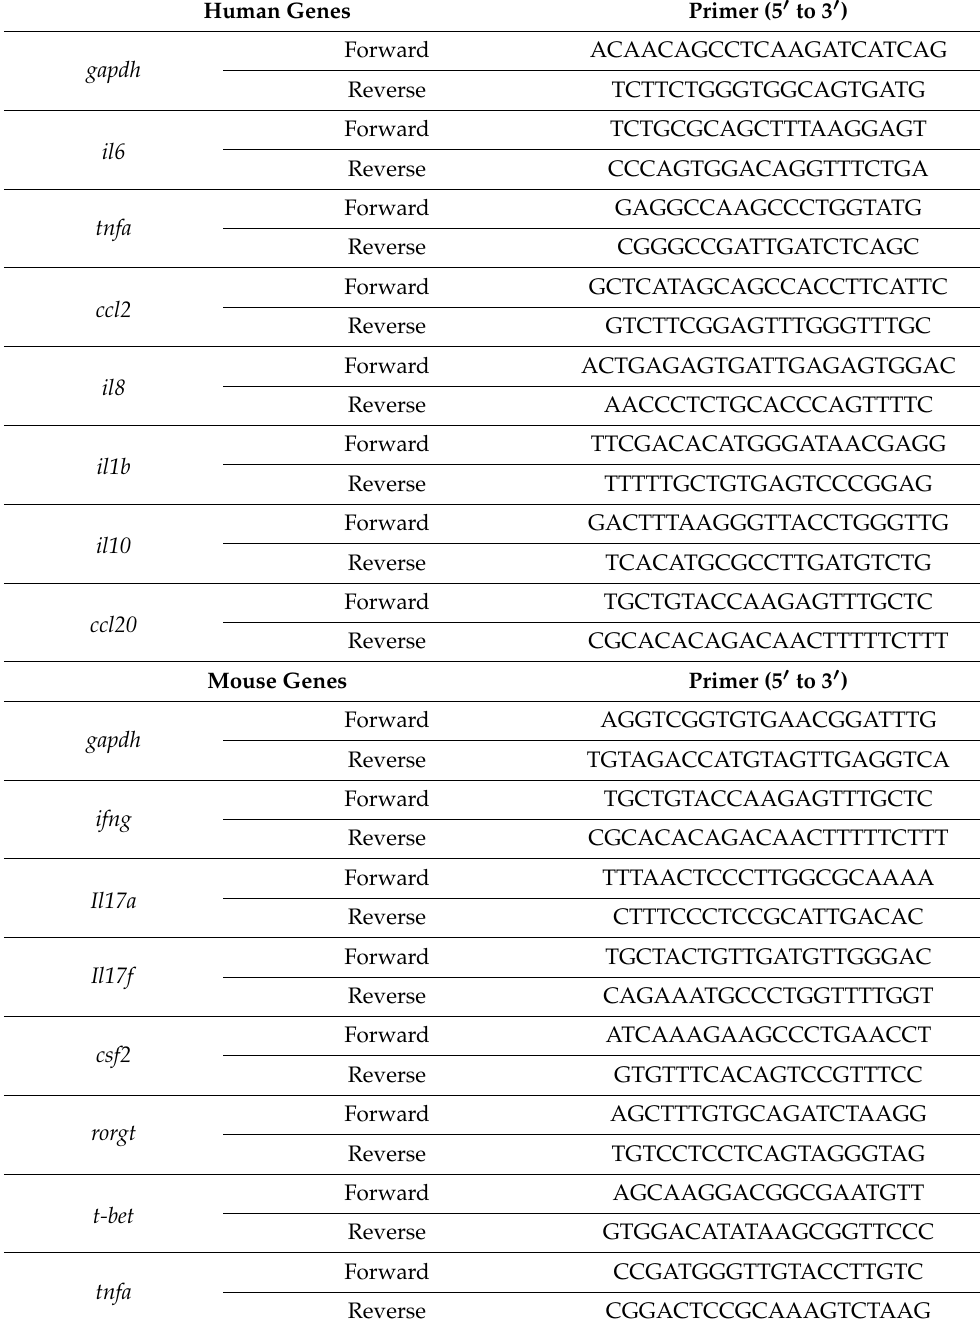
Table 1. Primer information. Human